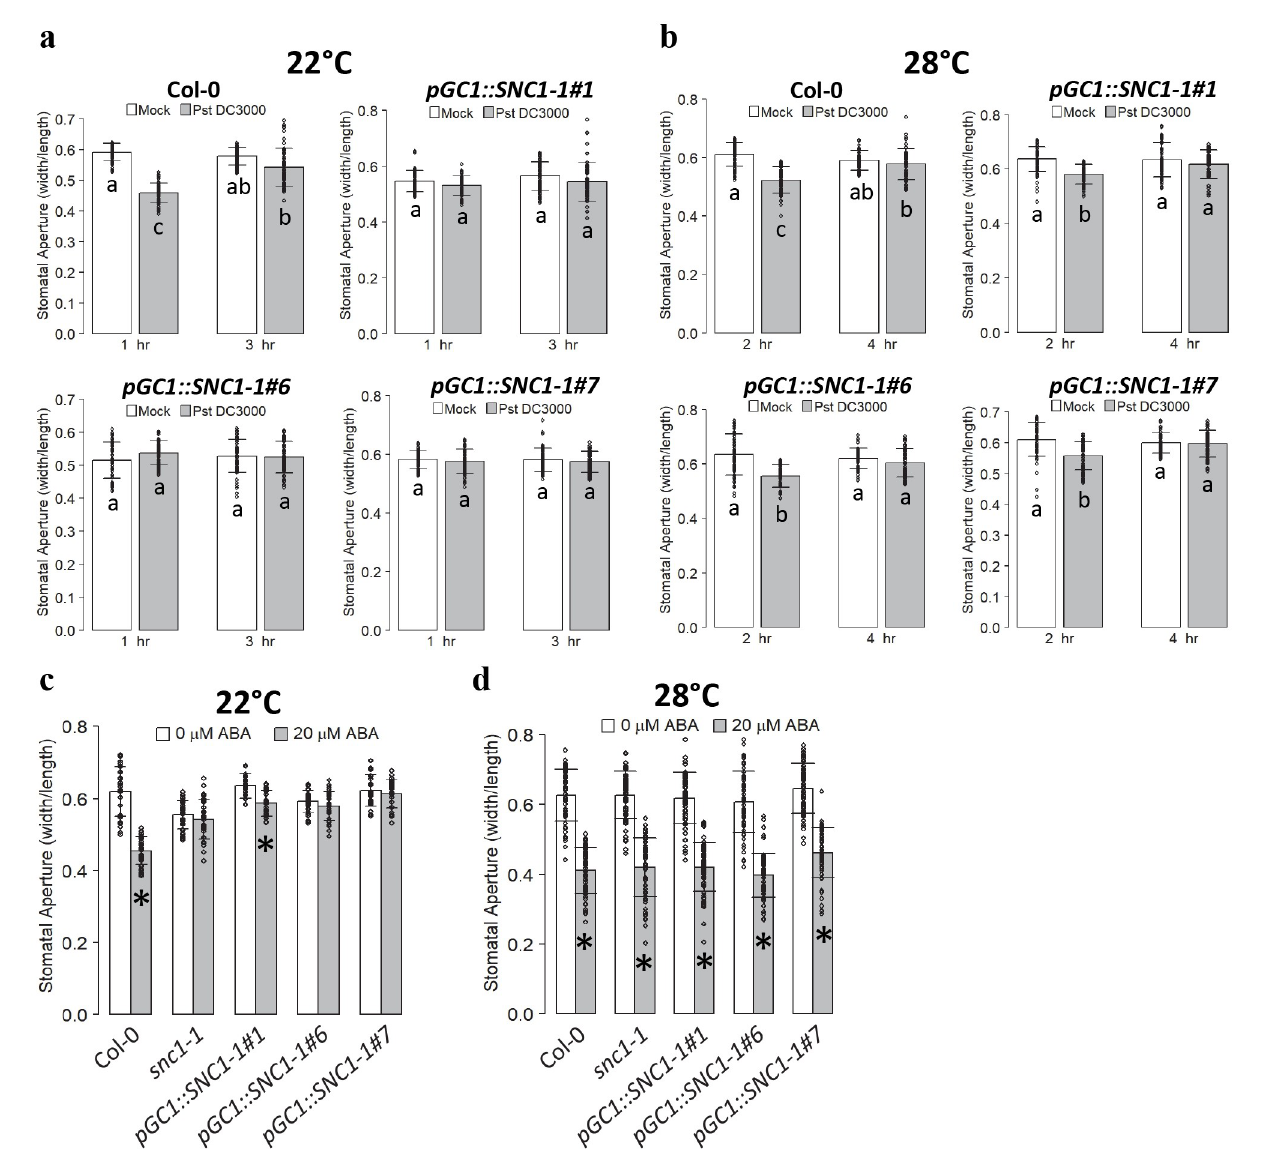
Fig 4. Expressing the active mutant gene SNC1-1 in guard cells results in stomatal closure defect. ( a , b ) Shown are stomatal apertures in response to Pst DC3000 or buffer alone (mock) in Col-0 and three independent pGC1 :: SNC1-1 transgenic lines (T3 generation) at 22˚C ( a ) and 28˚C ( b ) at indicated time points. Biological duplicates were averaged and statistically analyzed with one-way Anova followed by Tukey-Kramer test. Different letters indicate statistically significant difference ( p < 0.001), error bars indicate SDs (n = 60 stomata). ( c , d ) Shown are stomatal apertures in response to 20 μ M ABA or buffer alone (0 μ M ABA) in Col-0, snc1-1 and the three pGC1 :: SNC1-1 lines at 22˚C ( c ) and 28˚C ( d ) after 1.5 hr. Biological duplicates were averaged and statistically analyzed with Student’s t test. Asterisks indicate statistically significant differences in stomata aperture between 0 and 20 μ M ABA ( p < 0.001). Error bars indicate SDs (n = 60